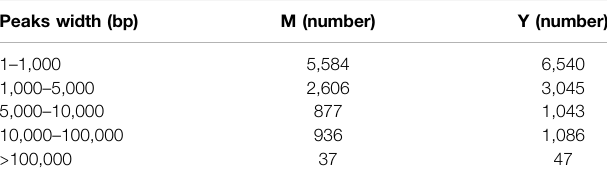
TABLE 1 | Statistical analyses of peak widths. Peaks width (bp) M